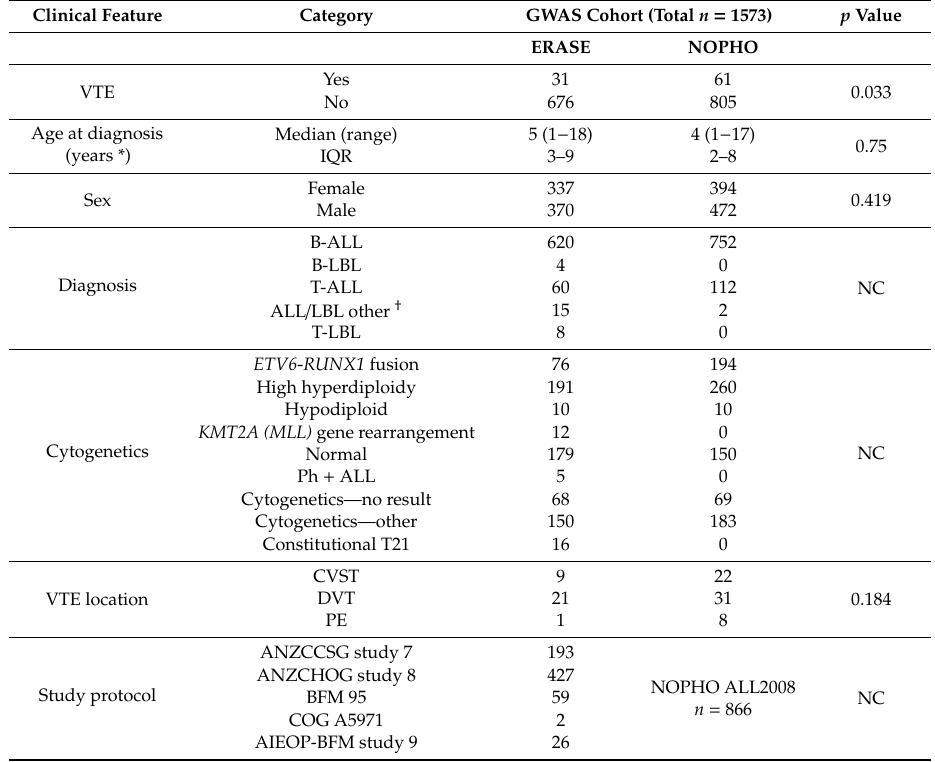
Table 1. Demographics of children and adolescents experiencing VTE * Age is rounded to closest year in the ERASE cohort, as initial age values were in months. † Other = lineage not known, includes mixed-phenotype acute leukemia ( n = 7 in ERASE cohort, n = 2 in NOPHO cohort), ALL / LBL (lineage not specified). For comparison of NOPHO and ERASE cohorts, two-sided p values < 0.05 were considered significant; NC = p value was not calculated. Abbreviations: IQR, interquartile range; ALL, acute lymphoblastic leukemia; LBL, lymphoblastic lymphoma; T21, Trisomy 21; Ph + ALL, Philadelphia chromosome (t(9;22) positive ALL; CVST, cerebral venous sinus thrombosis; DVT, deep venous thrombosis; PE, pulmonary embolus. ANZCCSG, Australian and New Zealand Children’s Cancer Study Group; ANZCHOG, Australian and New Zealand Children’s Hematology and Oncology Group; AIEOP, Associazone Italiana Ematologia Oncologia Pediatrica; BFM,